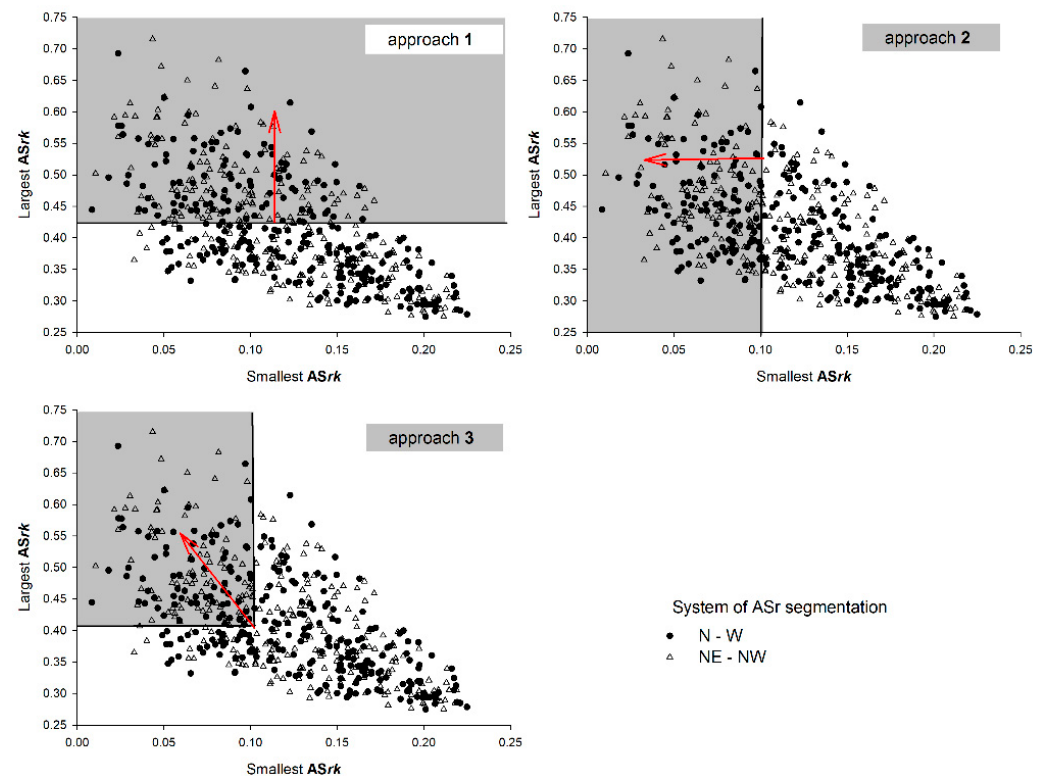
Figure 4. A graphical definition of approaches 1–3 used for tree filtering. Arrows and grey areas indicate the selection of trees based on irregularity of their social area (AS). The cluster of points where the smallest part of social area (AS rk ) is opposed to the largest part of each tree shows the regularity and irregularity of AS.